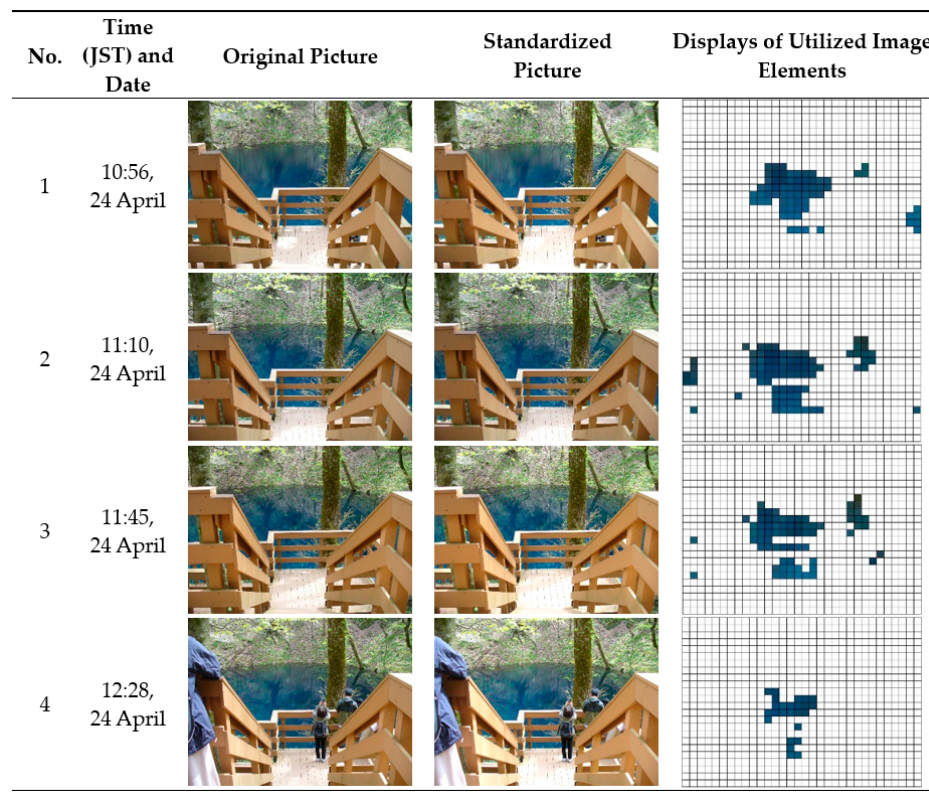
Figure 13. Original pictures, standardized pictures, and displays of utilized color elements.